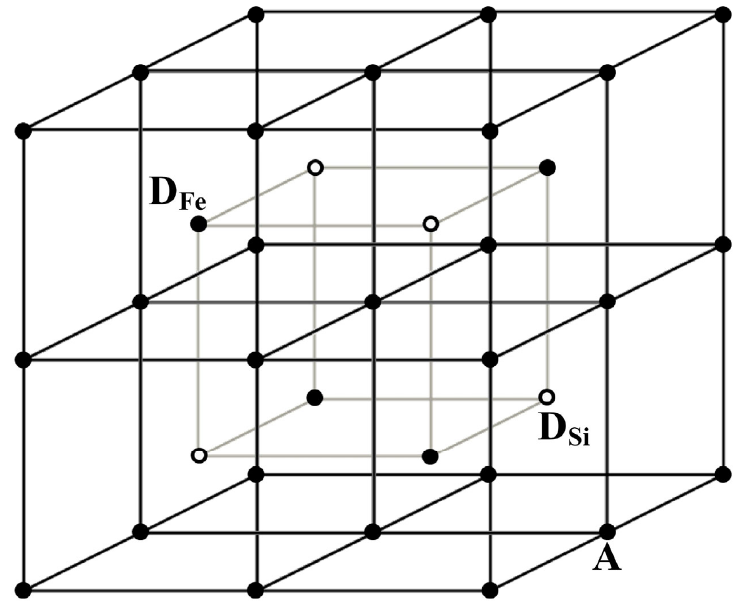
Figure 77. Scheme of α‐ Fe 3 Si with the ordered DO 3 structure. Black circles are iron atoms at the A and D Fe sites, while open circles are Si atoms at the D Si sites. Black lines connect atoms at the A sites, while light grey lines connect the D ‐ site atoms. Adapted from Ref. [102] with permission from Elsevier: Materials Chemistry and Physics, Vol. 180, Oshtrakh M.I., Klencsar Z.,